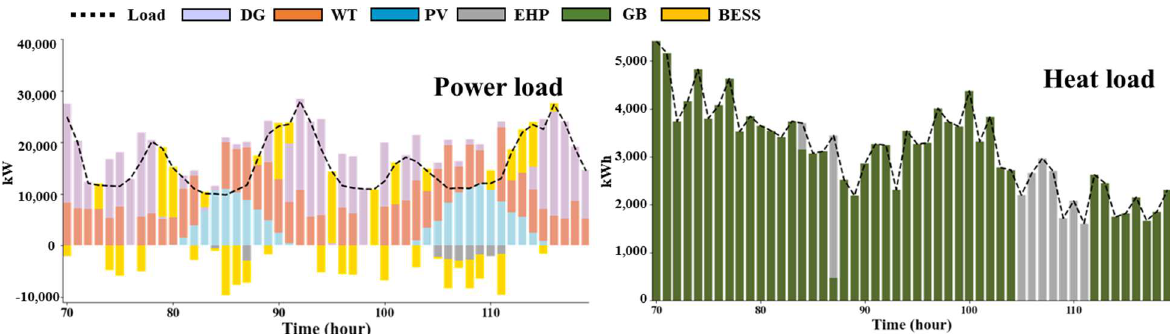
Figure 7. Results of power flow scheduling in Case 3.